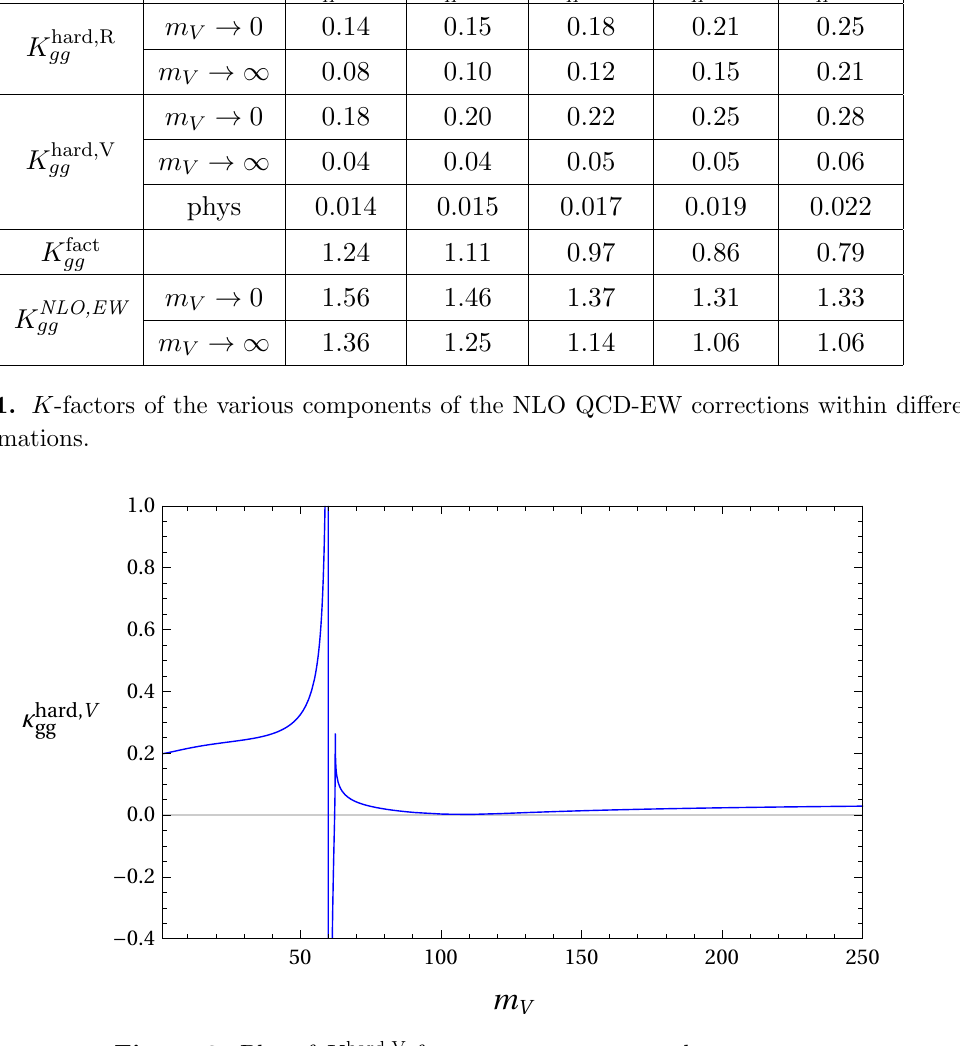
Figure 3. Plot of K hard ; V